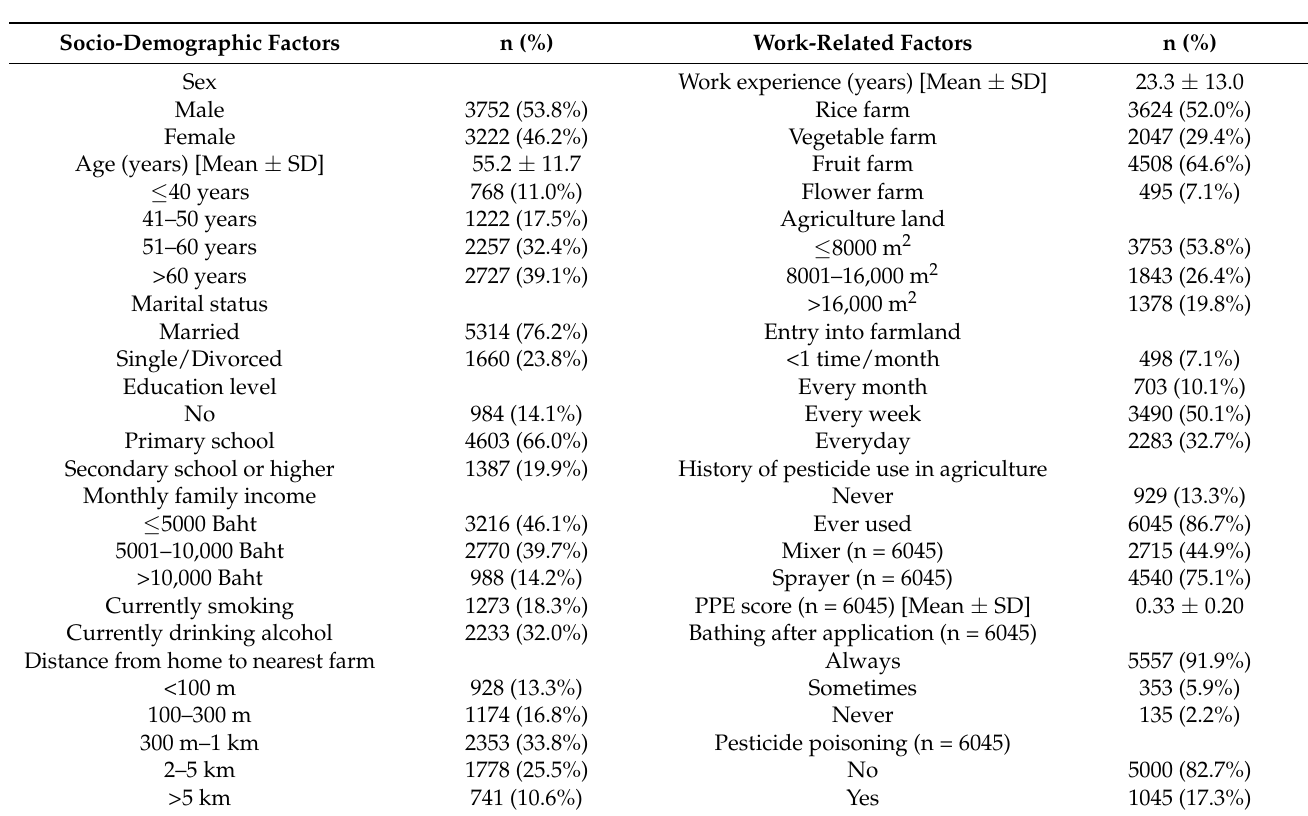
Table 1. General information of Thai farmers (n =